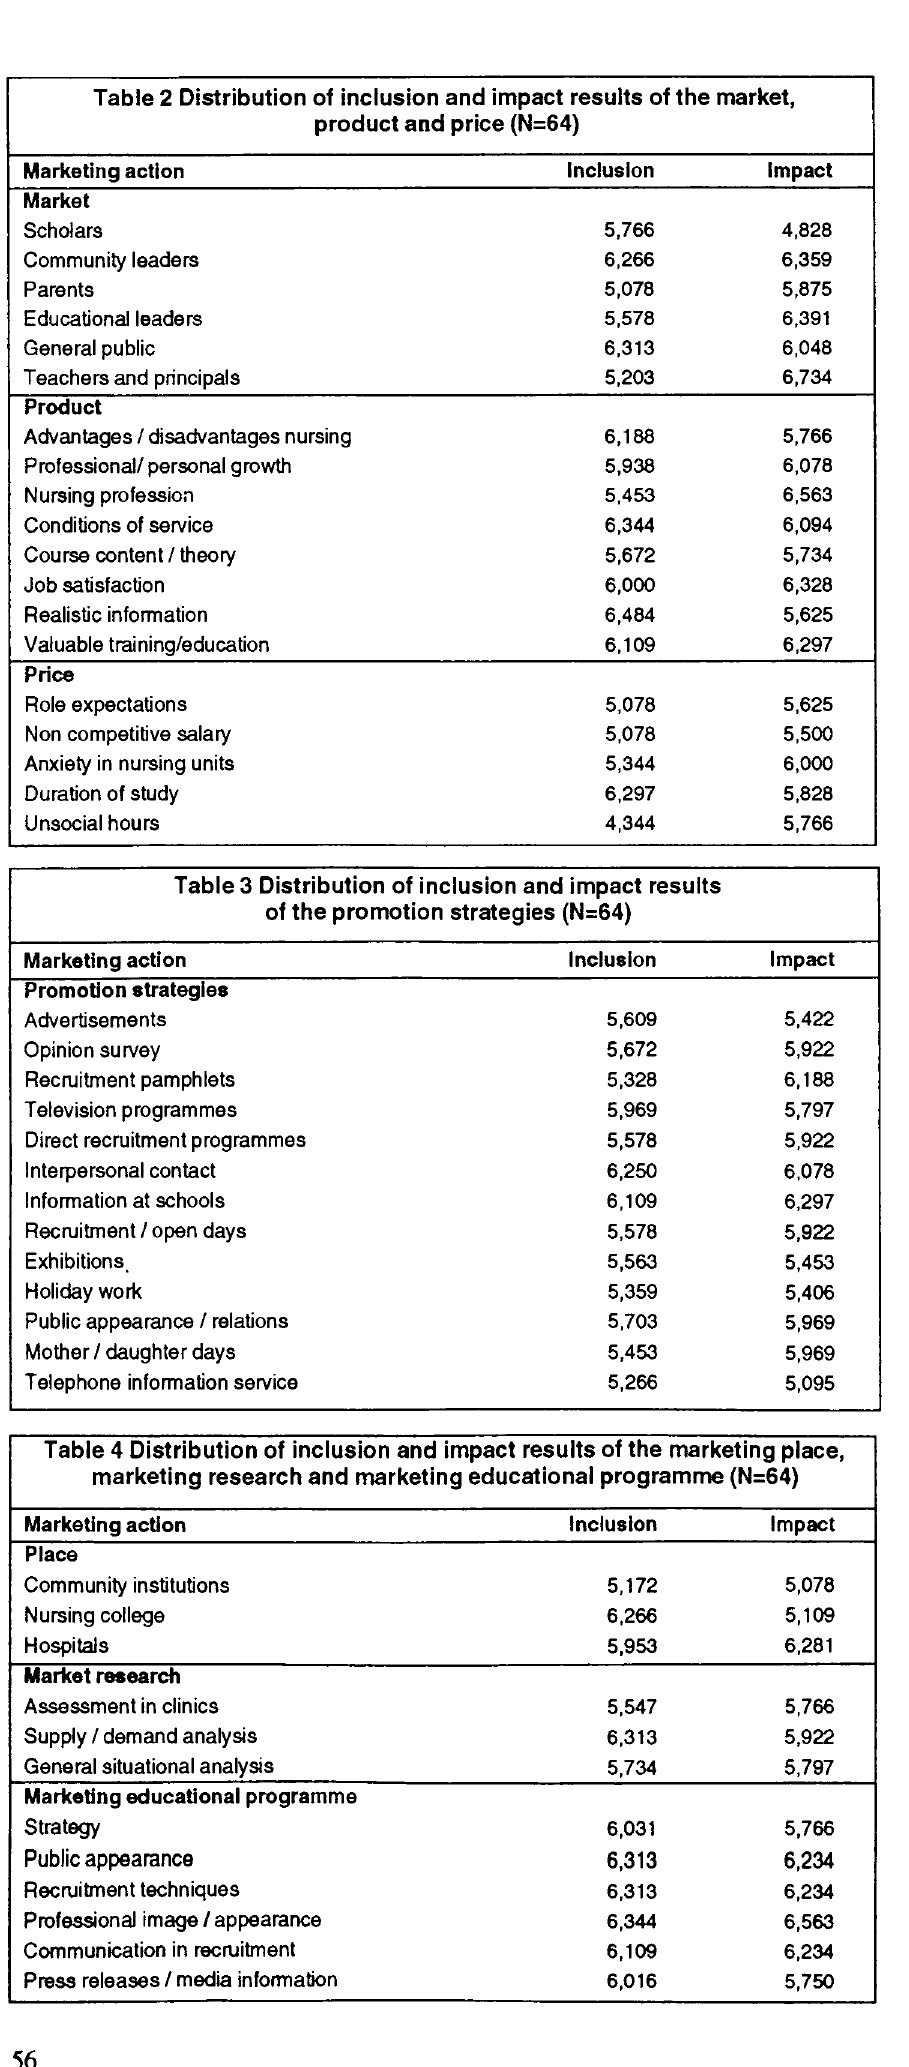
Table 2 Distribution of inclusion and impact results of the market,